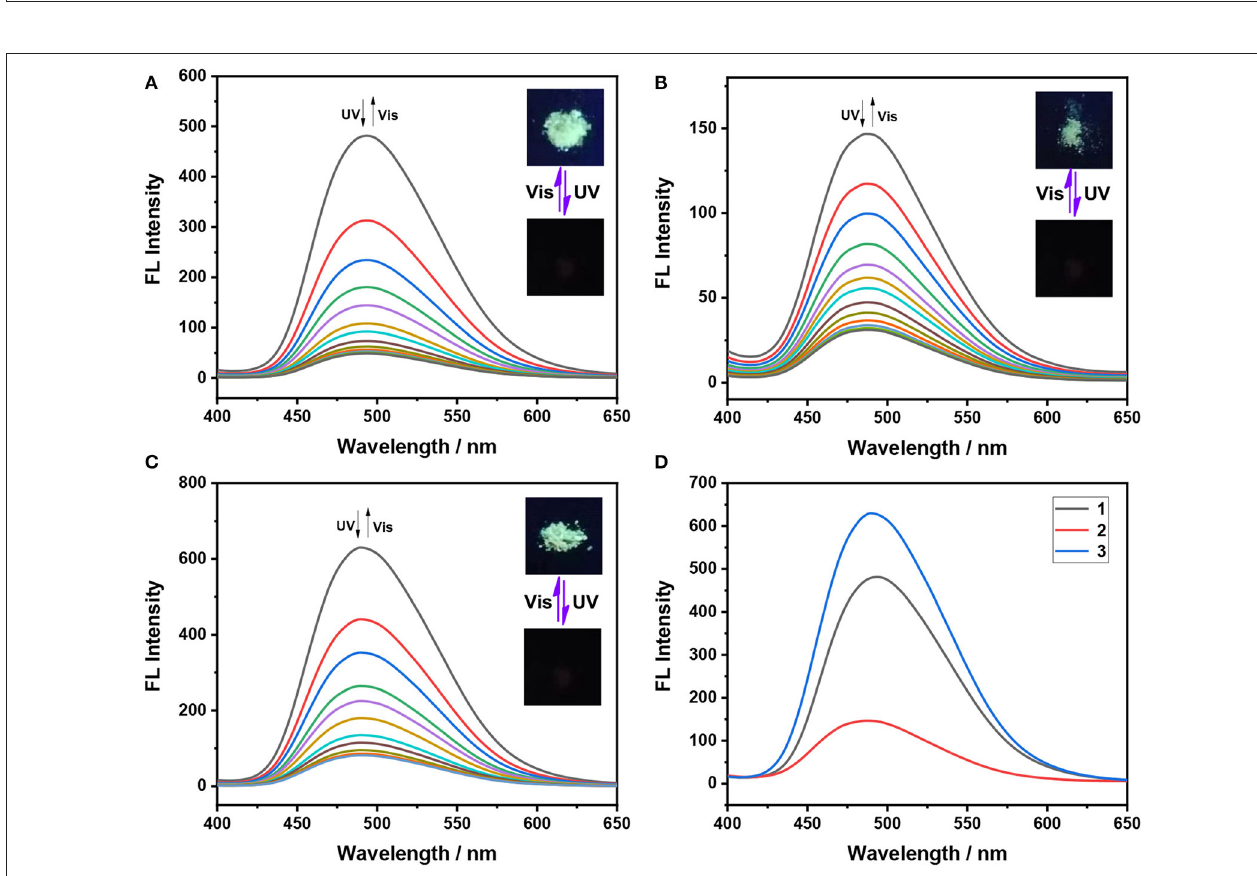
FIGURE 4 | Fluorescence spectra changes of dithienylethenes 1–3 in the solid state upon alternating irradiation with UV light at 365nm and visible light at > 402nm, (A) spectral changes for 1 (0–800s for the fluorescent-off state, irradiation interval: 40s; 0–1,200s for the fluorescent-on state, irradiation interval: 60s); (B) spectral changes for 2 (0–560s for the fluorescent-off state, irradiation interval: 40s; 0–960s for the fluorescent-on state, irradiation interval: 60s); (C) spectral changes for 3 (0–480s for the fluorescent-off state, irradiation interval: 40s; 0–720s for the fluorescent-on state, irradiation interval: 60s); (D) fluorescence emission spectra of ring-open isomers 1o − 3o in the solid state. (Inset) Corresponding fluorescent color changes upon photoirradiation in the powder state.